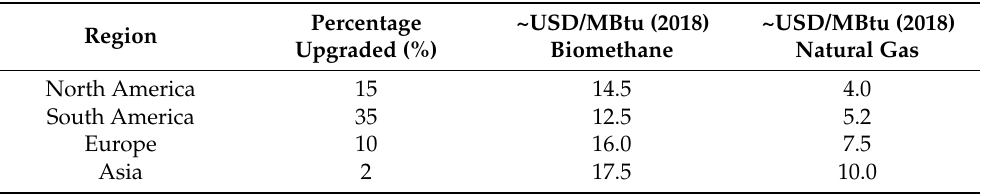
Table 2. Current regional variation of biogas upgrading to biomethane, including cost of production in 2018 prices, compared to the corresponding cost of natural gas. Data processed from [38], pp. 21, 38.